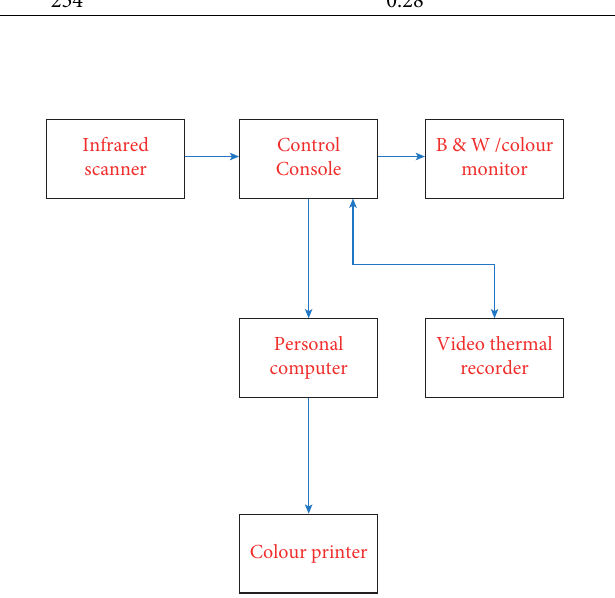
Figure 6: Illustration of thermography system.